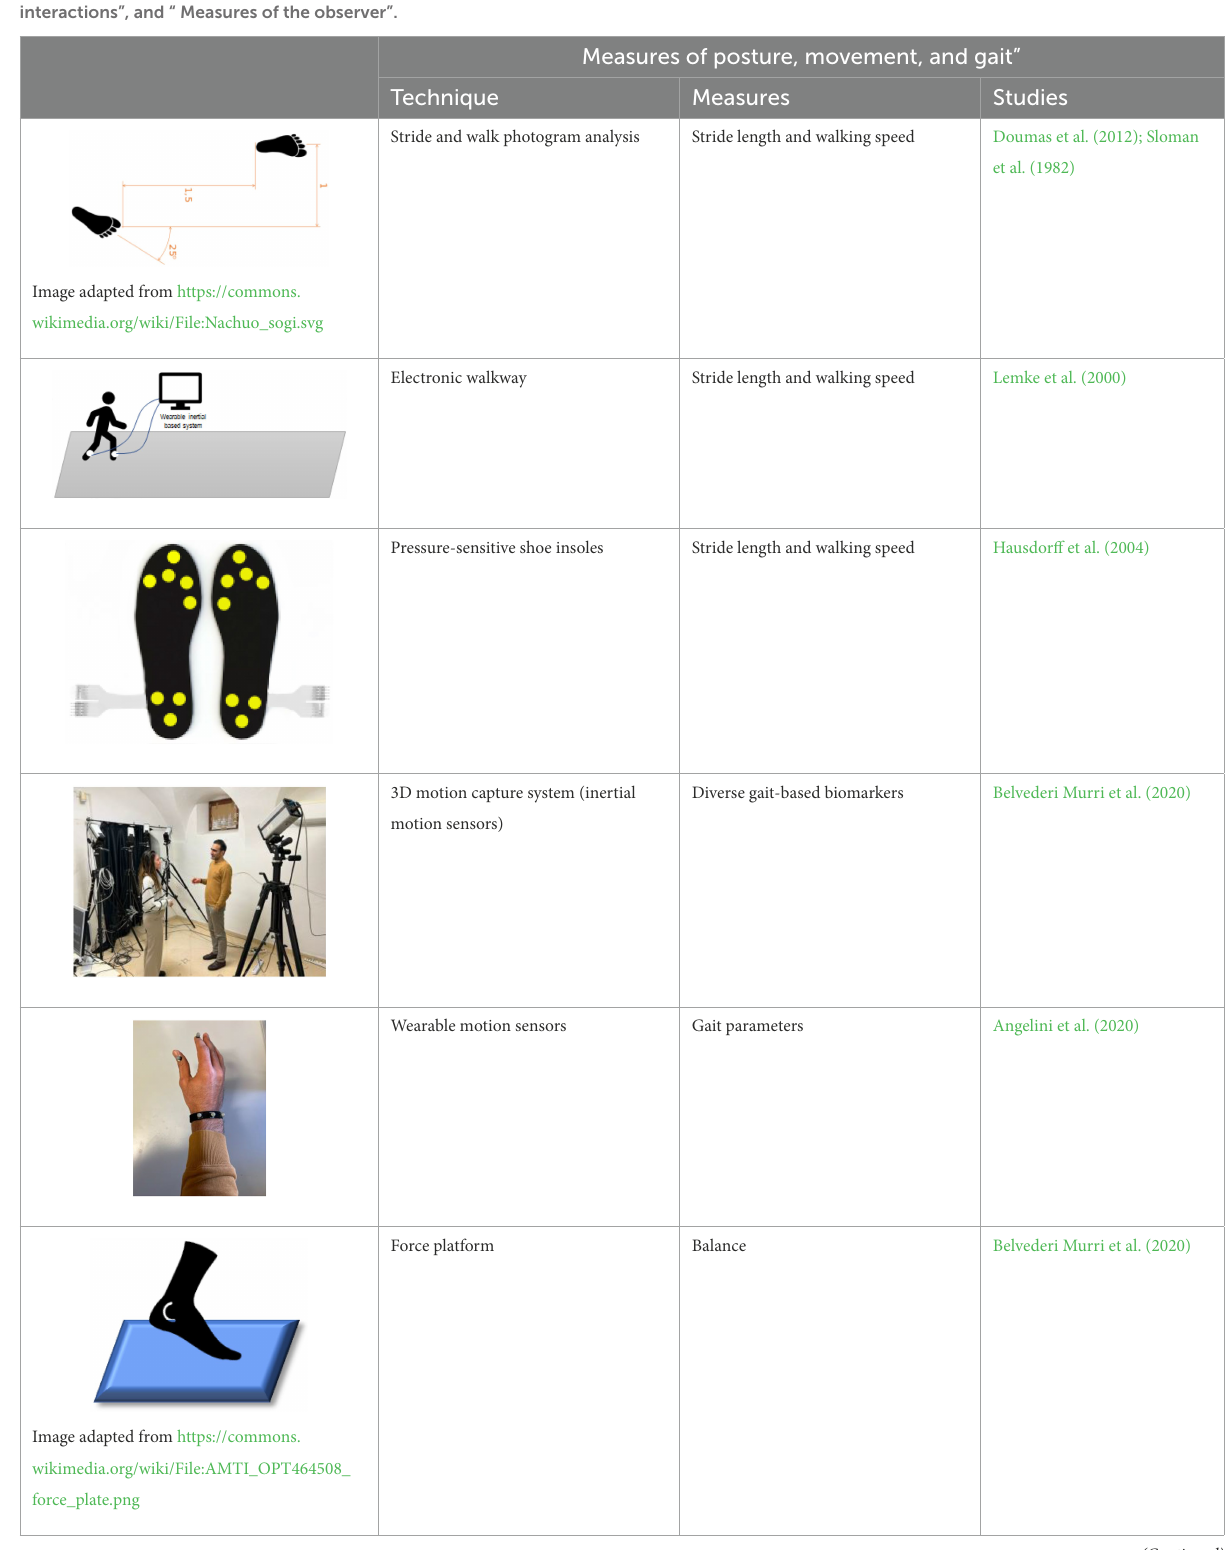
TABLE 3 Summary table of the techniques presented in sections “Measures of posture, movement, and gait”, “Measures of observed social interactions”, and “ Measures of the